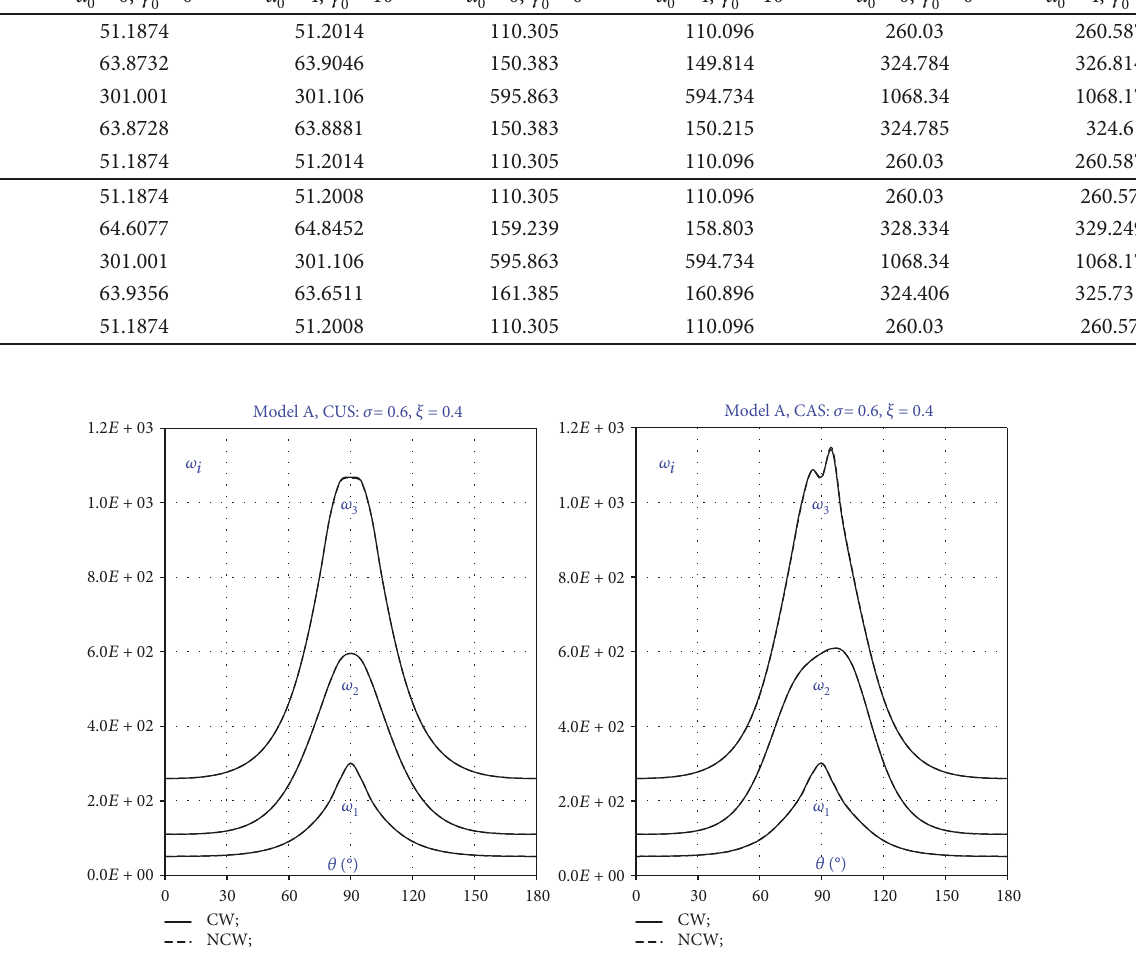
Figure 11: Eigenfrequencies vs. ply angle of Model A via CW and NCW for CUS and